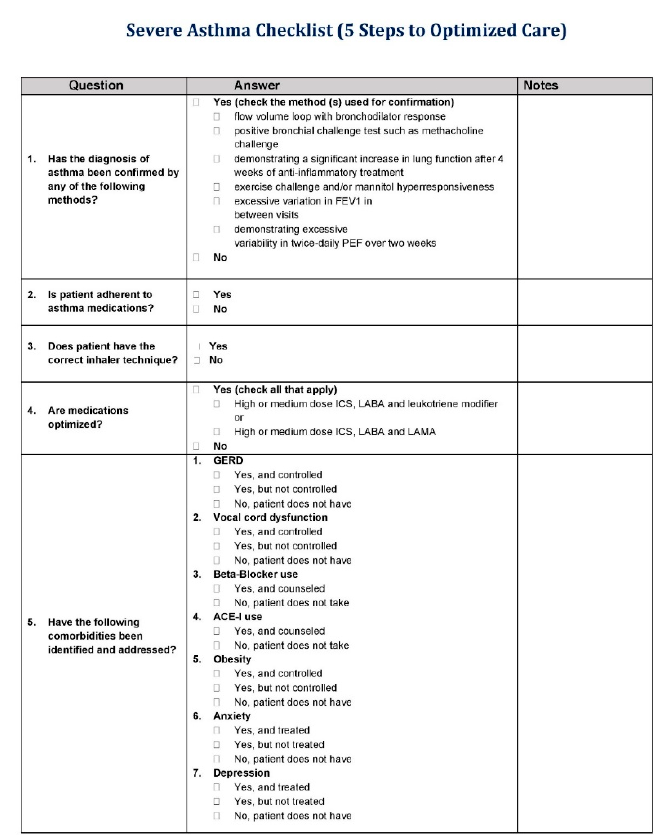
Figure A1. Sample Asthma Checklist.